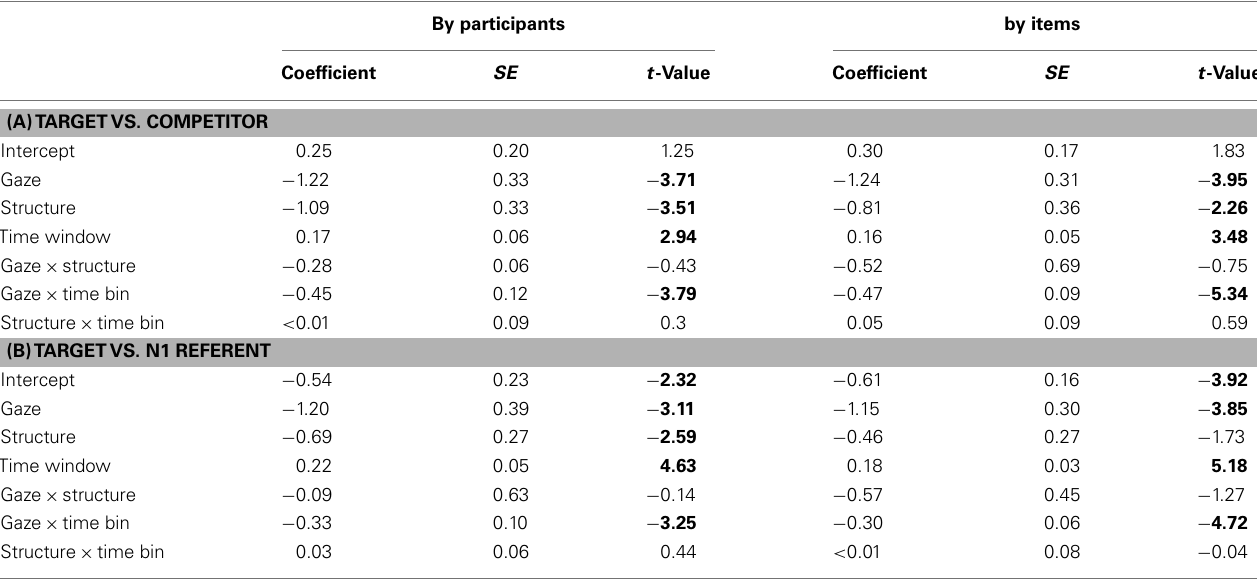
Table 3 | Experiment 1, SHIFT time window: Coefficients, SE and t -values for the final models of log-ratios of target fixations. By participants by items Coefficient SE t -Value